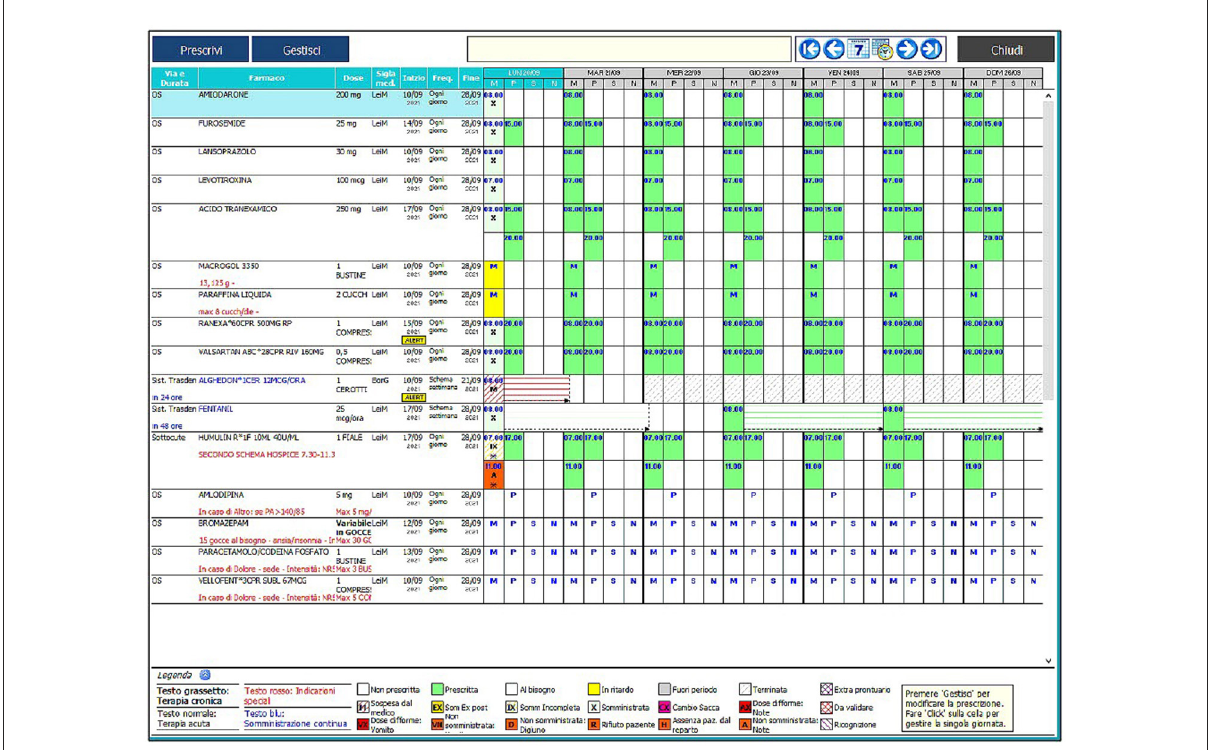
FIGURE1 The main screen of the unified electronic therapy record employed in the present